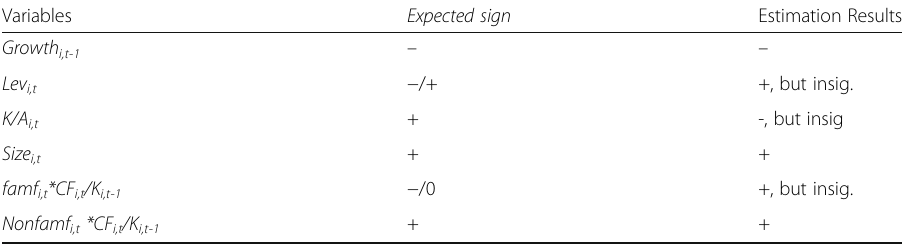
Table 5 Expected & Estimation Results Variables Expected sign Estimation